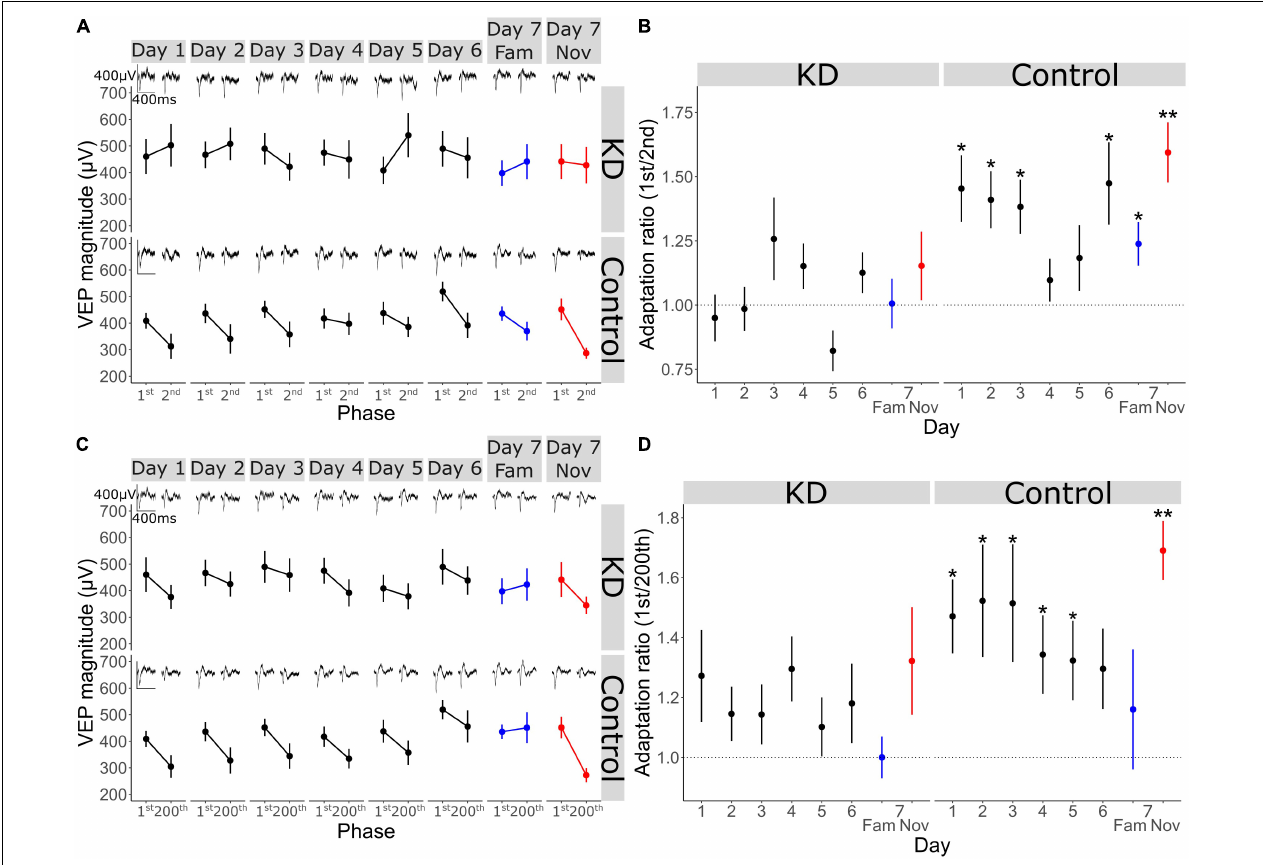
FIGURE 4 | V1 adaptation requires NMDA receptors in V1 across short timescales. (A) VEP magnitude in response to the 1st and 2nd phase reversal in GluN1 KD and WT group across all days ( n = 11) (B) adaptation ratio (1st/2nd) across days. Wilcoxon signed-rank test on AR ( µ = 1) in KD group on day 1: p = 0.6, day 2: p = 0.9, day 3: p = 0.5, day 4: p = 0.4, day 5: p = 0.4, day 6: p = 0.4, day 7 fam: p = 1, day 7 nov: p = 0.6. Wilcoxon signed-rank test on AR ( µ = 1) in WT group on day 1: p = 0.02, day 2: p = 0.01, day 3: p = 0.02, day 4: p = 0.2, day 5: p = 0.3, day 6: p = 0.03, day 7 fam: p = 0.03, day 7 nov: p = 0.008. FDR correction for multiple comparisons. (C) VEP magnitude in response to the 1st and 200th phase reversal in KD and WT group across all days. (D) Adaptation ratio (1st/200th) across days. Wilcoxon signed-rank test on AR ( µ = 1) in KD group on day 1: p = 0.3, day 2: p = 0.3, day 3: p = 0.3, day 4: p = 0.3, day 5: p = 0.5, day 6: p =